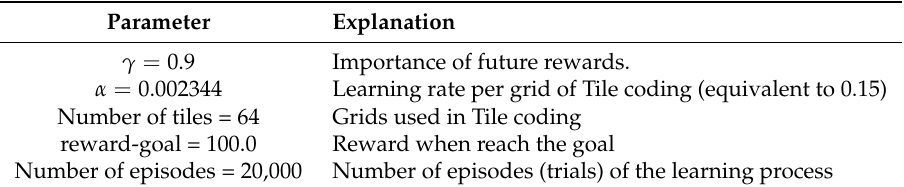
Table 2. Experiment